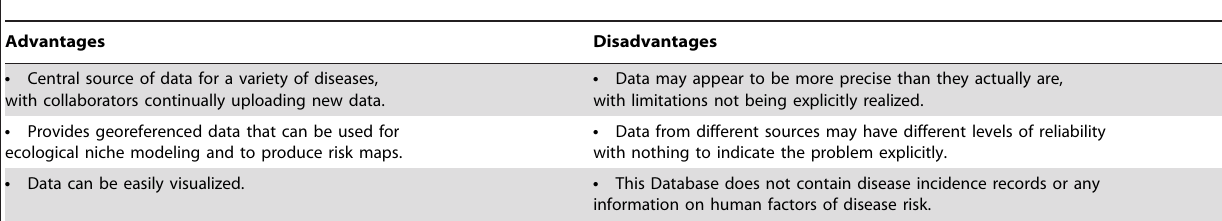
Table 2. Advantages and disadvantages of the Disease Vector Database.